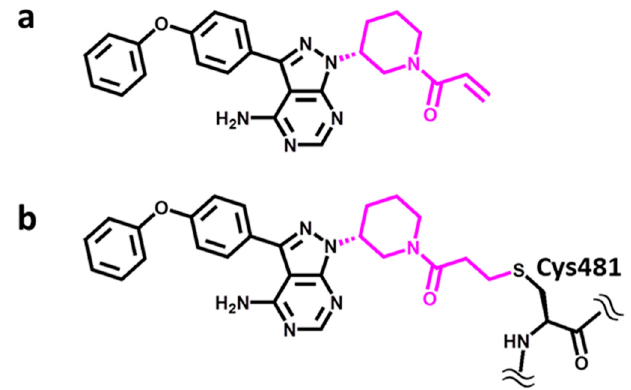
Figure 1. Structure of ibrutinib. The covalent drug ibrutinib contains an acrylamide warhead, colored magenta in ( a ), which forms a covalent bond to the thiol group of a Cys481 in BTK, shown in ( b